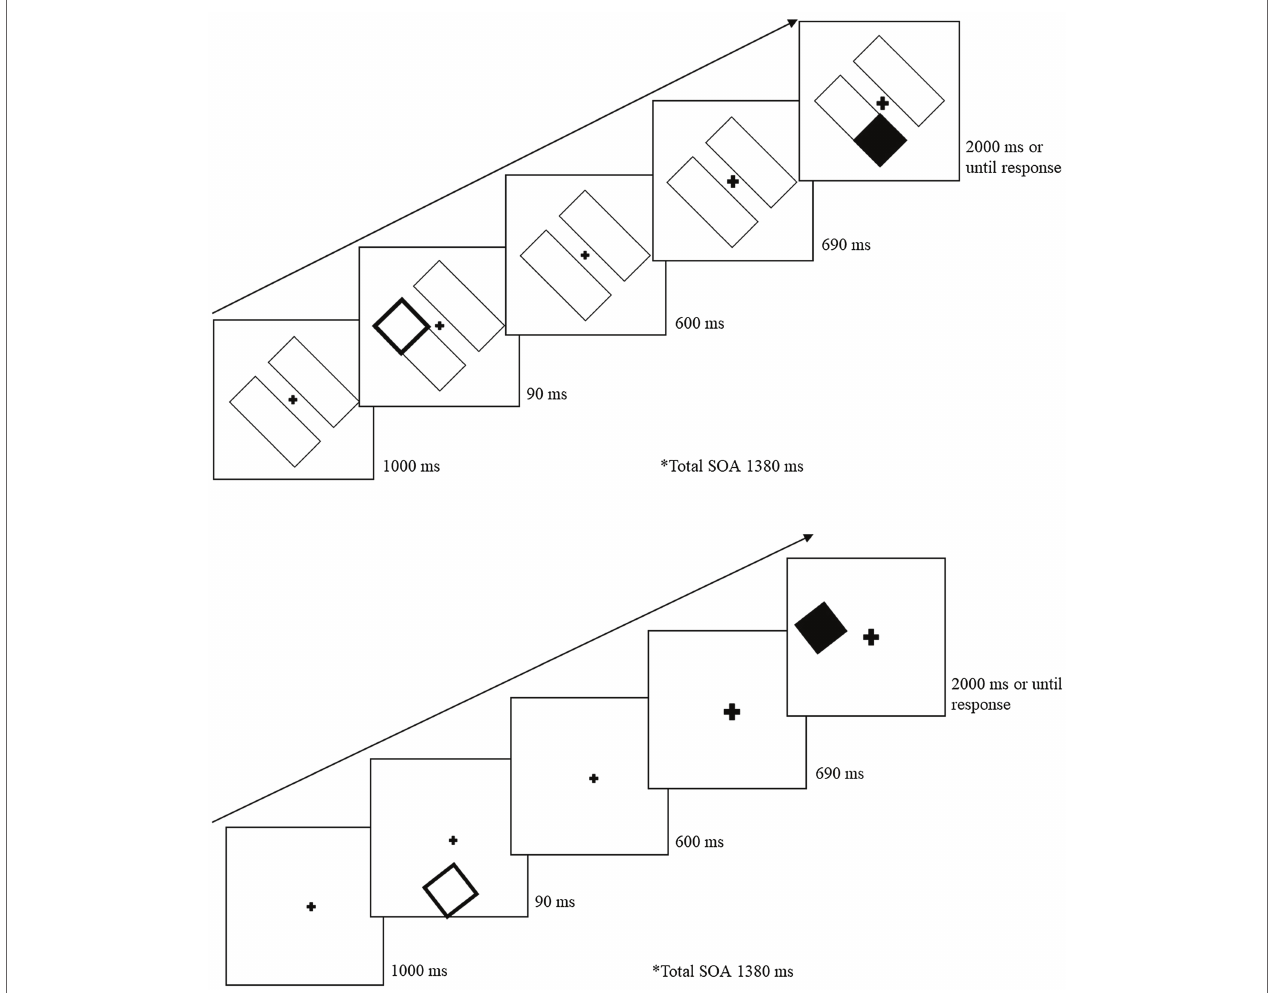
FIGURE 3 | Sample trial sequence for Experiment 2. After a 90 ms peripheral cue, the central fixation cross was cued (briefly increased in size) to draw attention back to the center. Following a 1,380 ms SOA from the peripheral cue, a target was presented on 80% of the total trials. For object-absent conditions (bottom image), the sequence and cue-target distances remained the same but there were no object